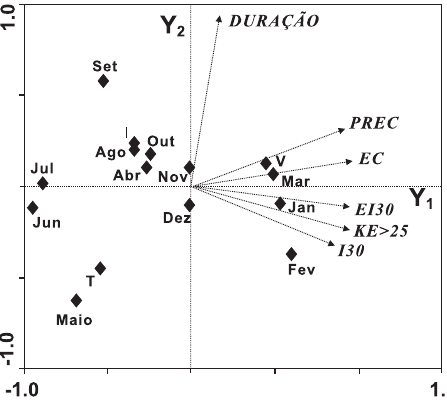
Figura 2. Análise de componentes principais para os dados de precipitação e erosividade das chuvas. V; I e T: padrões avançado, intermediário e atrasado,